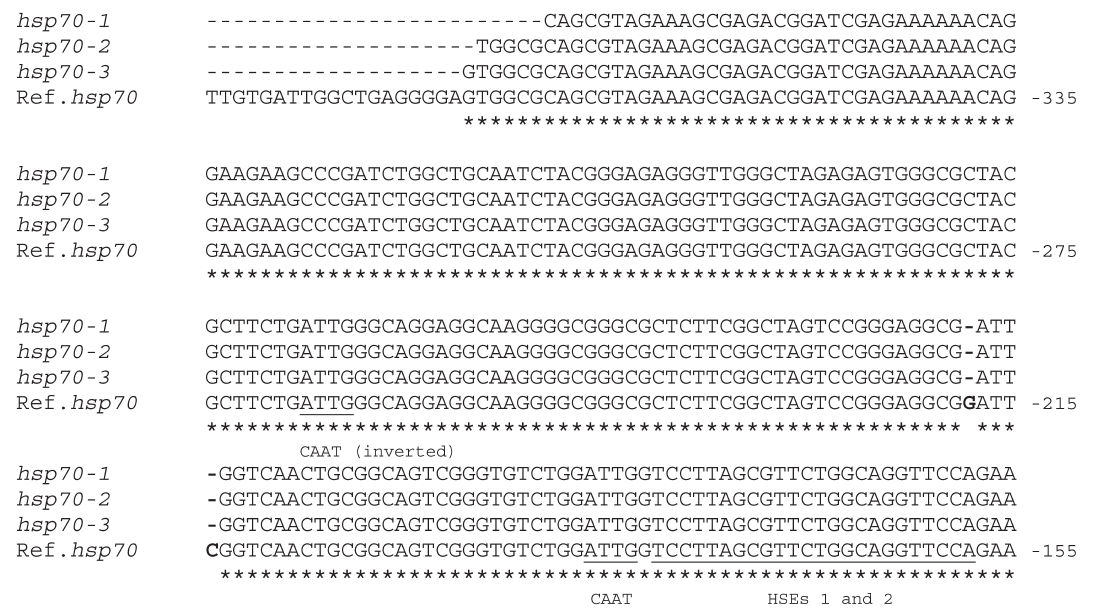
Figure 3 - Alignment (CLUSTALW) of alleles hsp70-1 , hsp70-2 and hsp70-3 with the reference sequence (J02579 - Morimoto et al. , 1986). Underlined: conserved regions CAAT, HSEs 1 and 2, TATA box and initial ATG; in bold: transitions and transversions seen among the three alleles and the reference hsp70